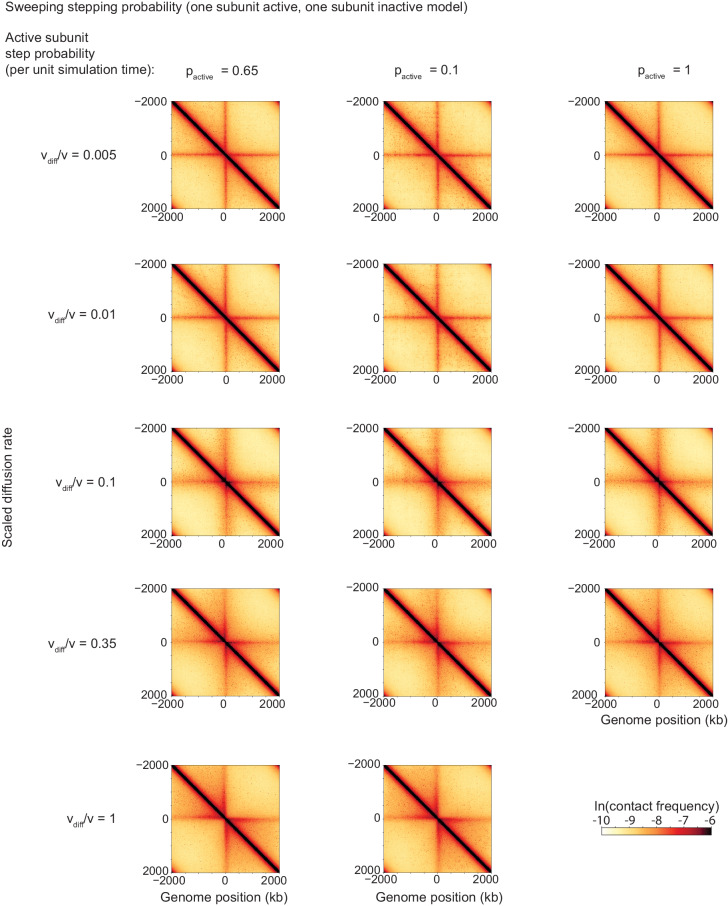
Contact maps from simulations for different values of the LEF stepping probability (per simulation step), with N = 5 LEFs on each chromosome.These results indicate that the scaled diffusion rate, vdiff/v is the invariant quantity giving the contact maps their shape in the case of the model of a semi-diffusive LEF.